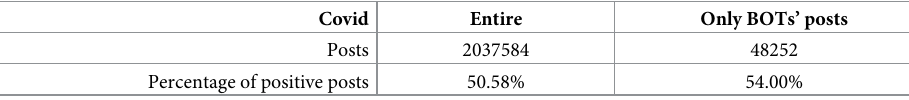
Table 3. “Covid” sample: Descriptives of the sample obtained with T =